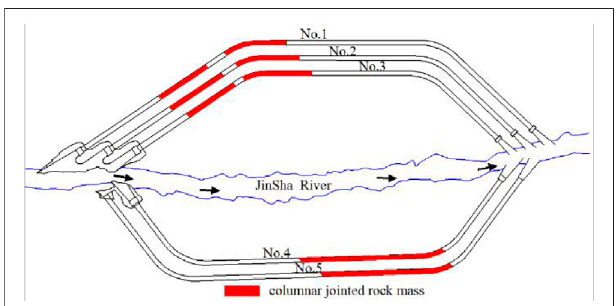
FIGURE2| Distribution planofdiversiontunnelofBaihetanHydropower Station.